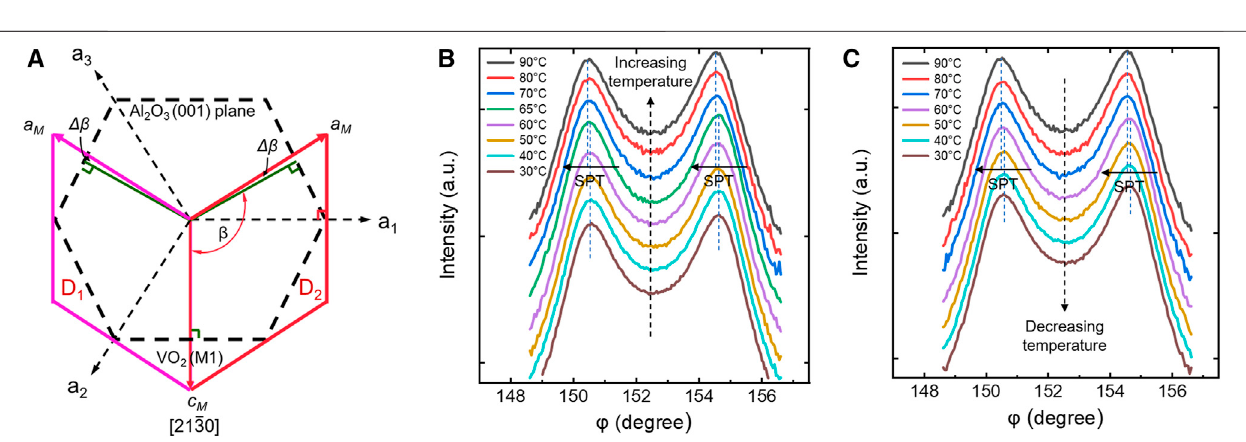
FIGURE3|(A) Schematicdiagramofonetypical domainstructure patternoftheVO 2 (M1)epitaxialthin fi lmontheAl 2 O 3 (0001)interface. Local φ scansoftheVO 2 (011) re fl ection under the (B) heating and (C) cooling